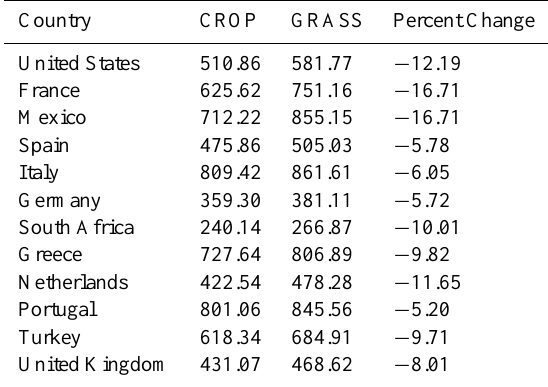
Table 2. Root-mean-squared error of GPP for selected regions from CROP and GRASS simulations, as compared with MODIS satellite data of Zhao et al. (2005).